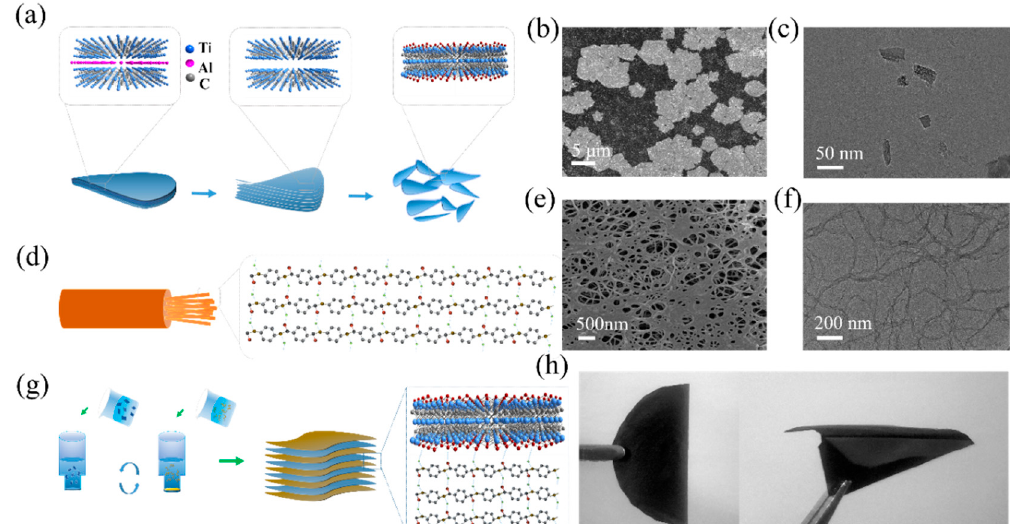
Figure 1. ( a ) Schematic illustration of the synthesis of Ti 3 C 2 T x by chemical etching; ( b , c ) SEM and TEM images of d-Ti 3 C 2 T x ; ( d ) preparation of ANF dispersion by deprotonation; ( e , f ) SEM and TEM images of ANFs; ( g ) preparation of ANF/MXene multilayer-structure films by vacuum-assisted filtration; ( h ) digital image of multilayer-structure film under folding.